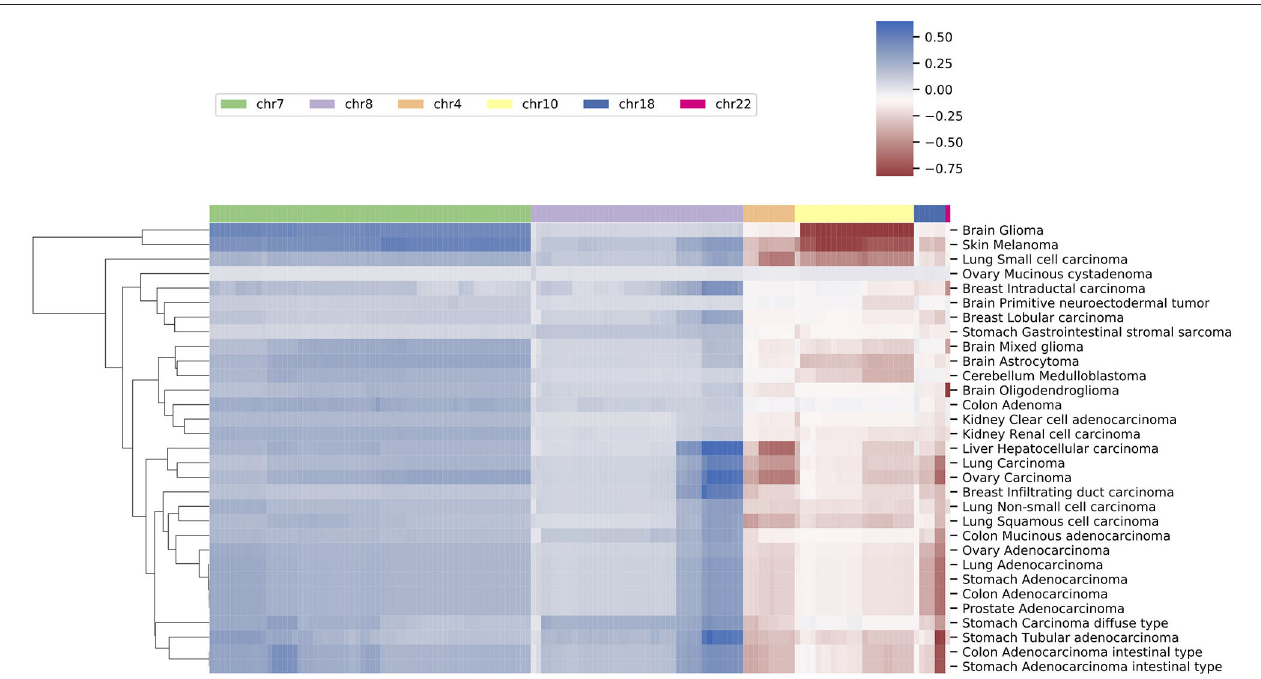
FIGURE 4 | The average copy number alternation level of the hot-zone features among different cancer subtypes. The values were calculated using the mean of the normalized CNV log ratios of all samples in each